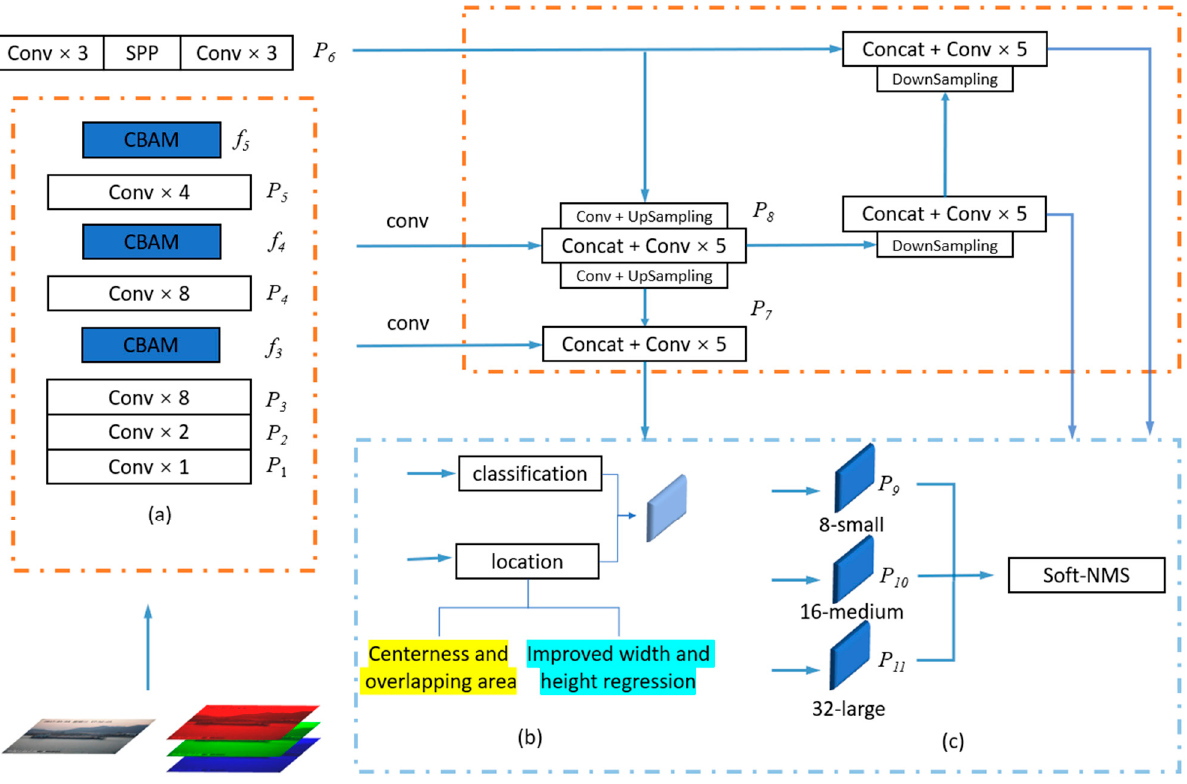
Figure 1. Algorithm structure diagram of EA-YOLOv4; ( a ) improvement of feature extraction network; ( b ) improvement of loss function; ( c ) improvement of loss function.